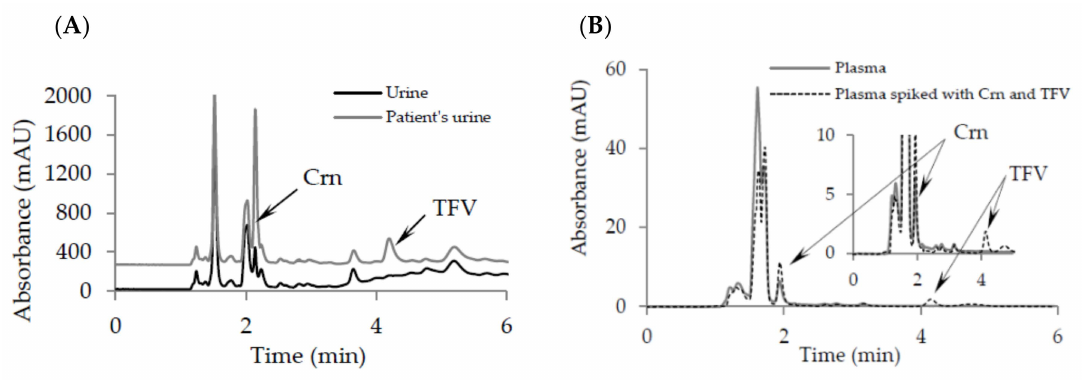
Figure 2. Representative chromatograms of: ( A ) urine, patient’s urine and patient’s urine spiked with TFV; ( B ) plasma and plasma spiked with Crn and TFV. Chromatographic conditions in Section